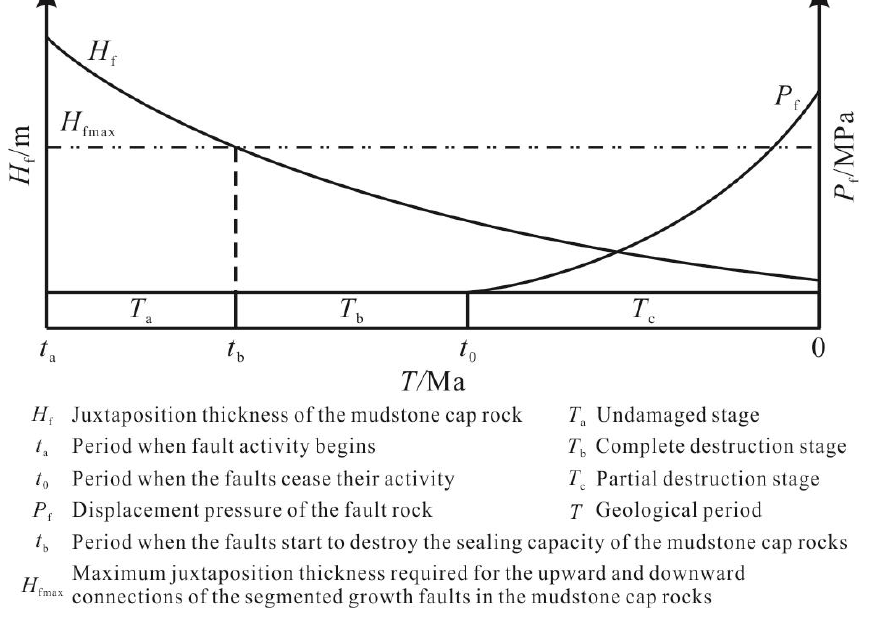
Figure 2. Stages of division of the sealing ability of mudstone cap rocks destroyed by faults.